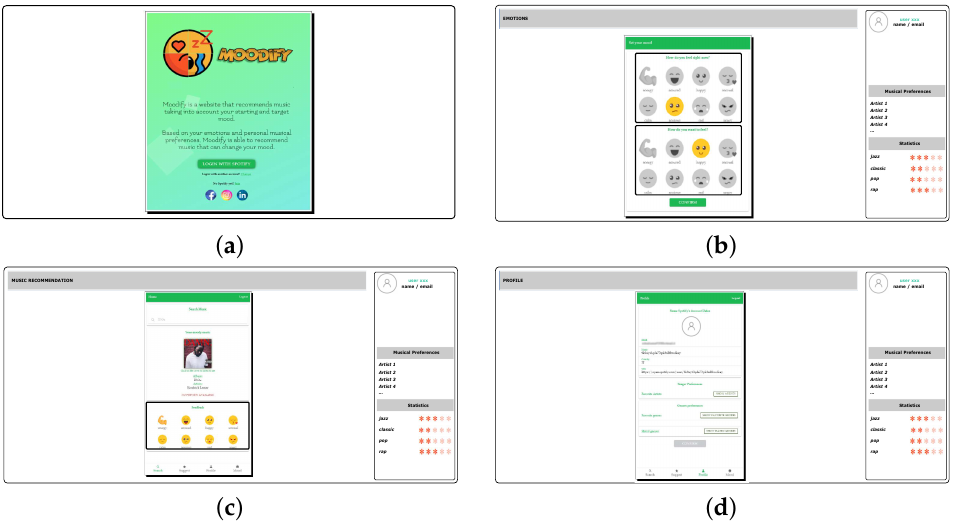
Figure 4. MoodifyWeb user interface with main functionalities. ( a ) The login page. Here the user accesses our application. The access can be made with Facebook, Spotify, or Google accounts; ( b ) The emotions page. Here the user selects his/her current emotion and the target emotion; ( c ) The music recommendation page. Here the song to listen to is recommended, and the user can give feedback to the system in terms of which emotions have been felt; ( d ) The profile page. The user can update personal